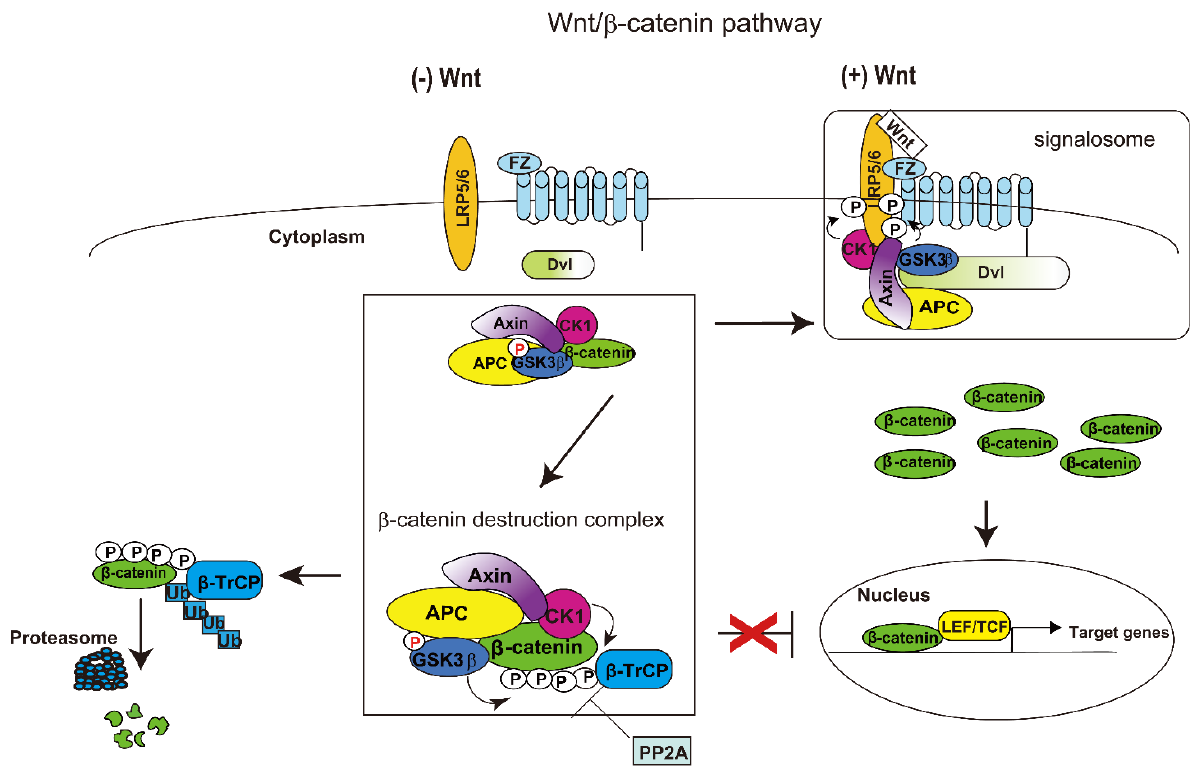
Figure 1. Wnt/ β -catenin signaling pathway. The ( left side ) shows signaling in the absence of Wnt. In the absence of Wnt signals, β -catenin is degraded by a complex of proteins comprising APC, Axin, CK1, GSK3 β , β -catenin, and β -TrCP (the E3-ubiquitin ligase). The rectangle shows the β -catenin destruction complex. Tyrosine phosphorylated GSK3 β is active. Sequential phosphorylation of β -catenin by CK1 and GSK3 β triggers its ubiquitination by the β -TrCP complex. Ubiquitylated and phosphorylated β -catenin is degraded by the proteasome. PP2A dephosphorylates β -catenin and